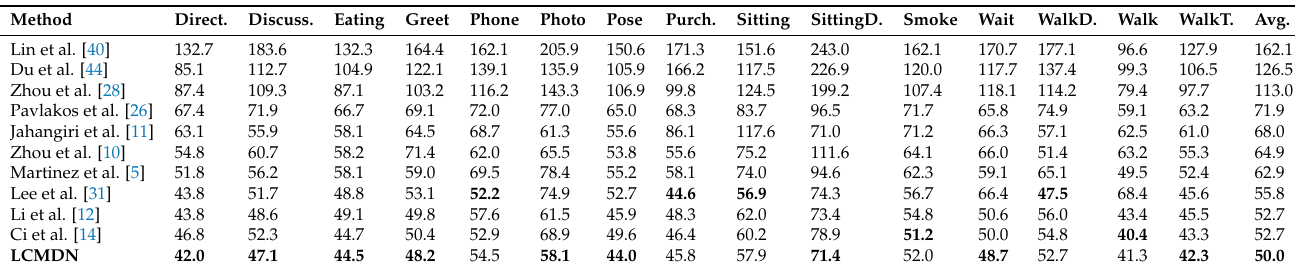
Table 1. The numerical results under protocol # 1 and comparisons on the Human3.6M dataset (mm). (Best result in bold.)